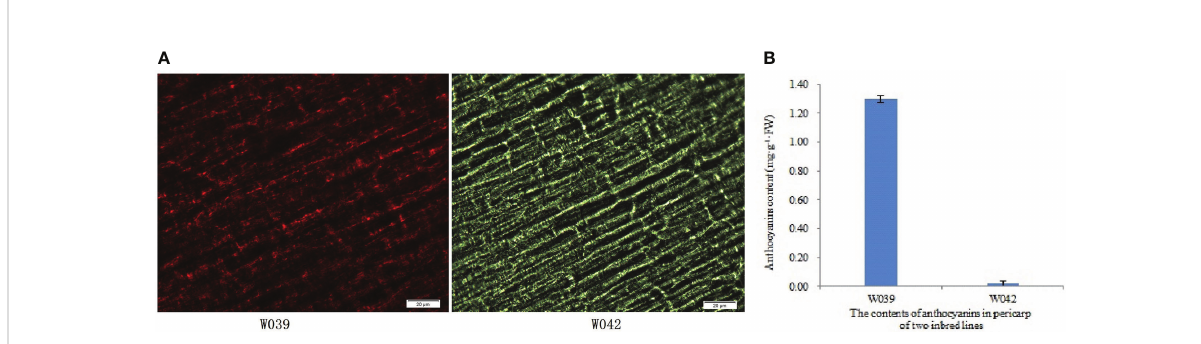
FIGURE 1 Phenotypic analysis and anthocyanins contents in pericarps of inbred lines W039 and W042. The letter (A) indicated the phenotypic observation results. The letter (B) showed the anthocyanins content in the pericarps of inbred lines W039 and